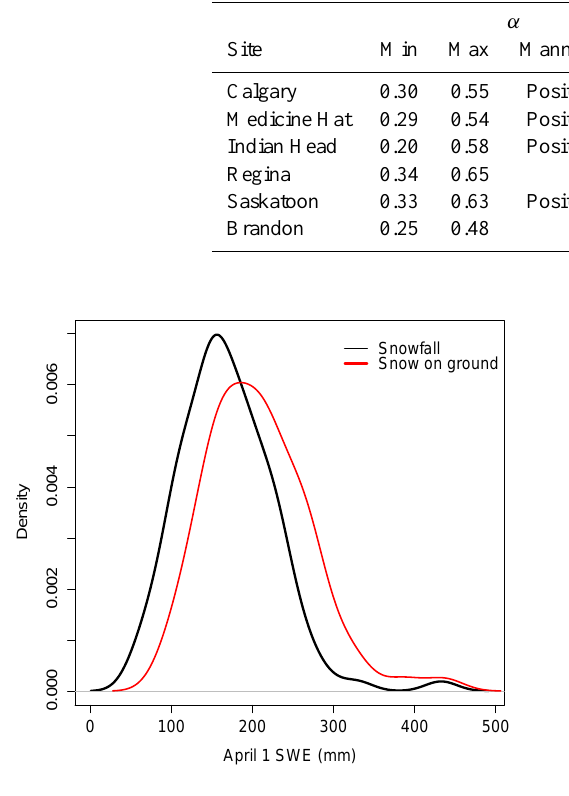
Fig. 6b. Density plot of 1 March cumulative seasonal snowfall at Edmonton, AB and snow on ground at Bellis snow course (1974– 2009). The horizontal distance between the two sites is approxi- mately 15km, and the difference in elevation is less than